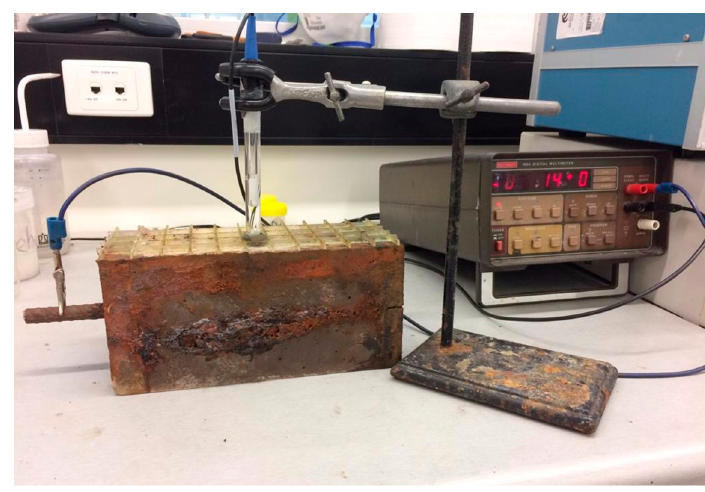
Figure 17. Half-cell potential corrosion measurement.